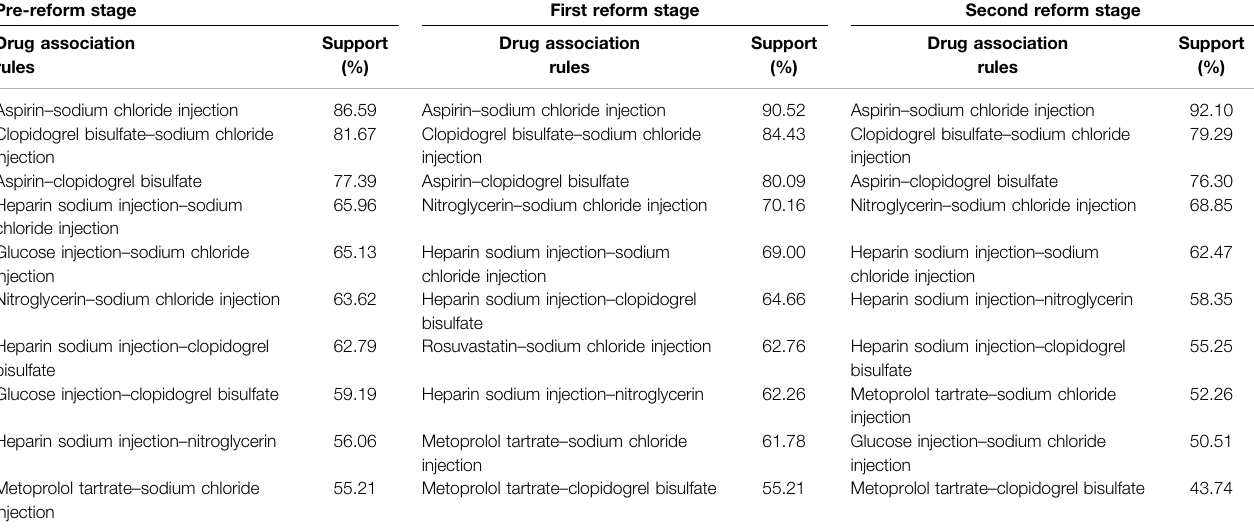
TABLE 2 | Supporting degree of DHI combined with two drugs based on association